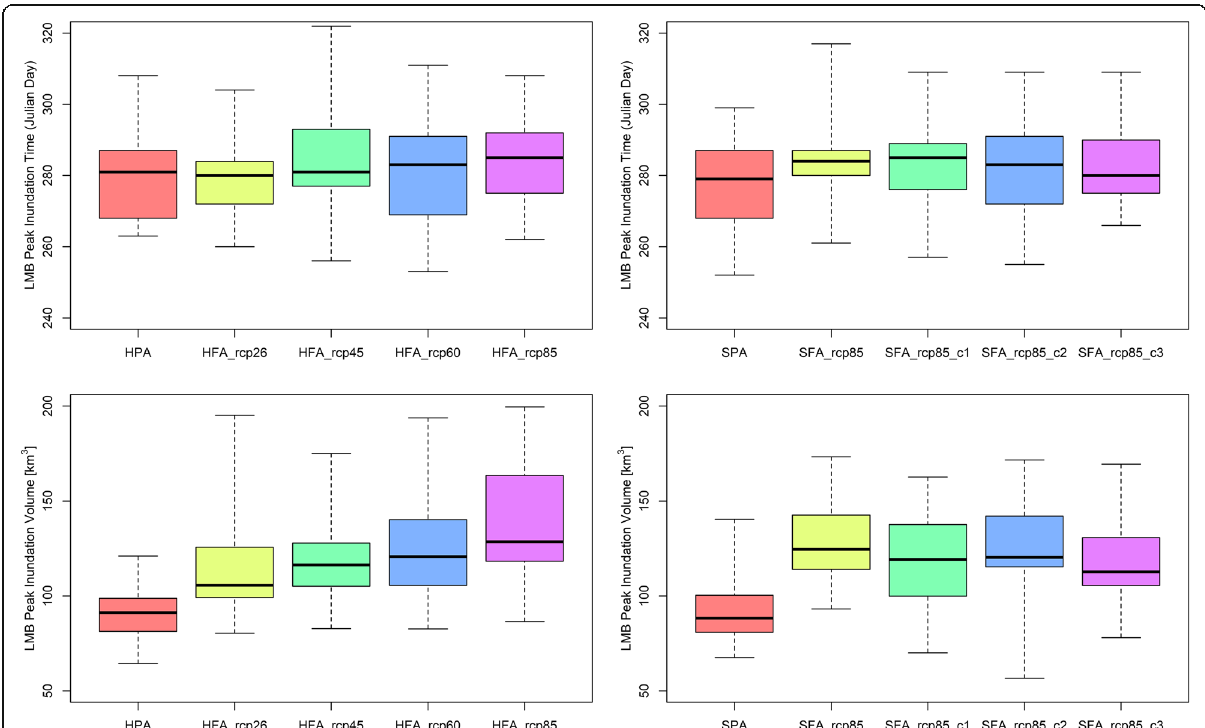
Fig. 8 Peak inundation time (upper row) and peak inundation volume (lower row) in the LMB resulted from MRI-AGCM3.2H model (left column) and MRI-AGCM3.2S model (right column). The boxplot explanation is the same as Fig. 5